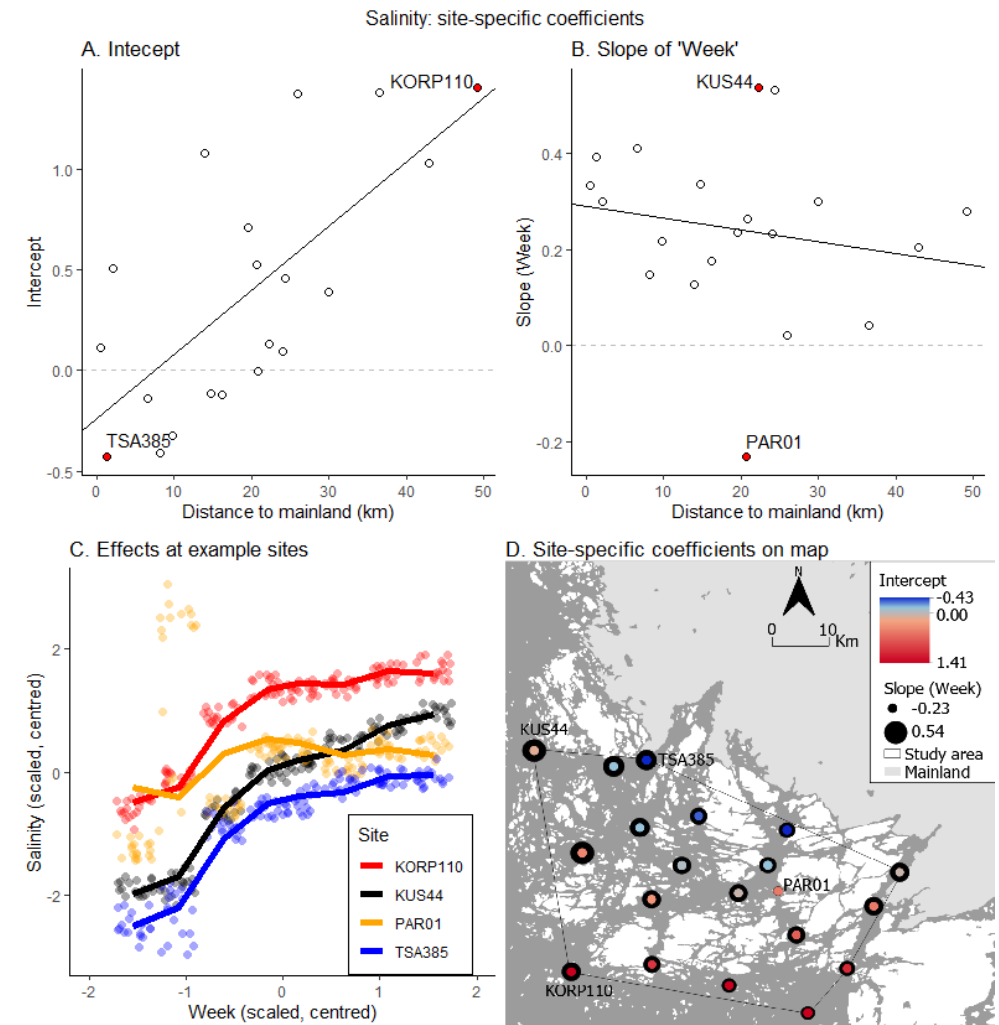
Figure 5. Salinity random coefficients and the partial effect of “week” in the random slope model: ( A ) site-specific intercepts, ( B ) site-specific slopes for the first-order term, ( C ) the main effects of “week” on salinity at four very different sites and ( D ) coefficients on a map. The four different sites highlighted in the figure are “KORPP110” and “TSA385” with highest and lowest intercepts, respectively, and “KUS44” and “PAR01” with highest and lowest slopes for “week”, respectively. Note that all coefficients and effects are at the scale of scaled and centred variables.